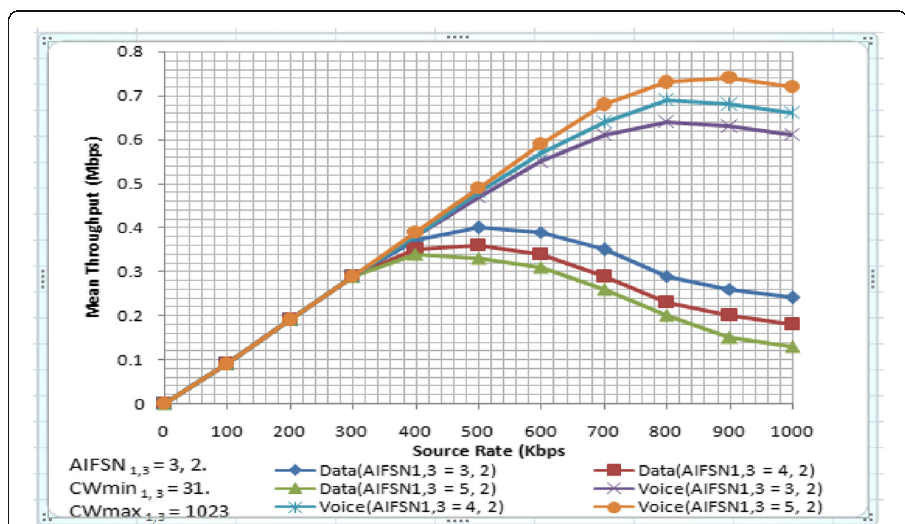
Fig. 12 Average throughput of BE and VO traffic at varied AIFSN versus source